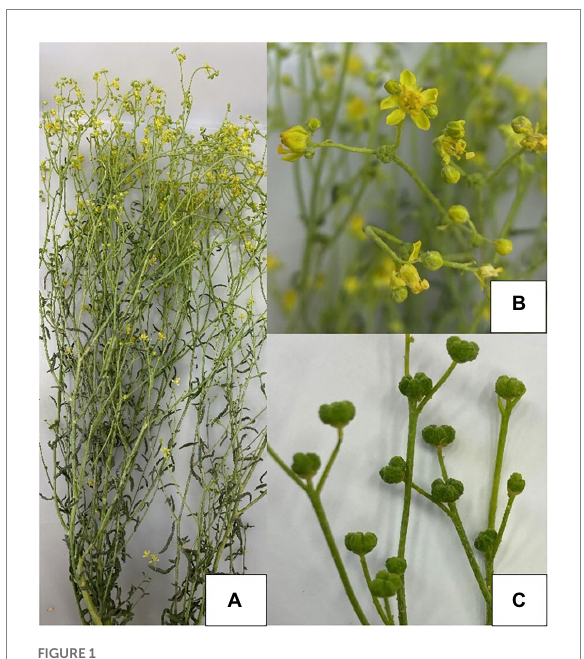
FIGURE 1 Meseika ( H. tuberculatum ), Doha, Qatar. (A) Whole plant, (B) Flowers, (C) Immature seed